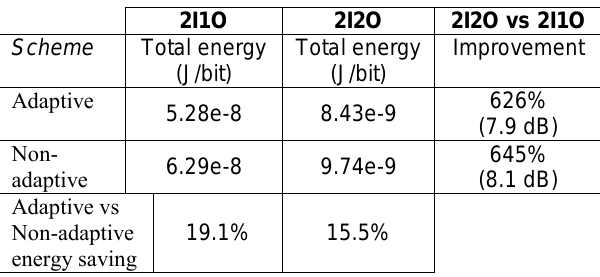
Table 4. Comparison between Energy Efficiency of Adaptive and Non-adaptive WBAN System in 2I1O and 2I2O at Distance 4